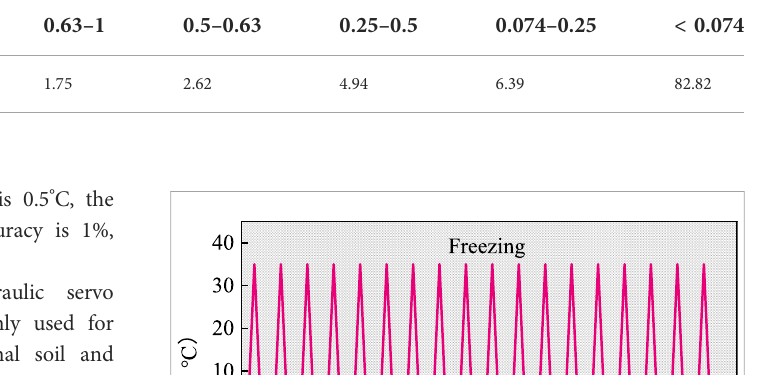
TABLE 2 Particle size distribution of soil.